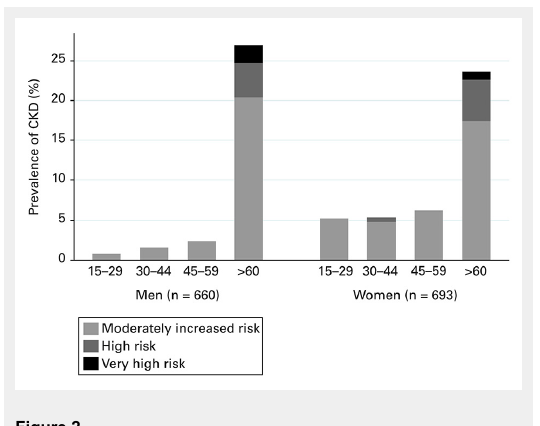
Prevalence of chronic kidney disease (KDIGO 2012), by gender and age category. p-values are from a nonparametric test for trend, comparing the trend in combined medium- to very high-risk categories vs low-risk category across age groups KDIGO = Kidney Disease – Improving Global Outcomes